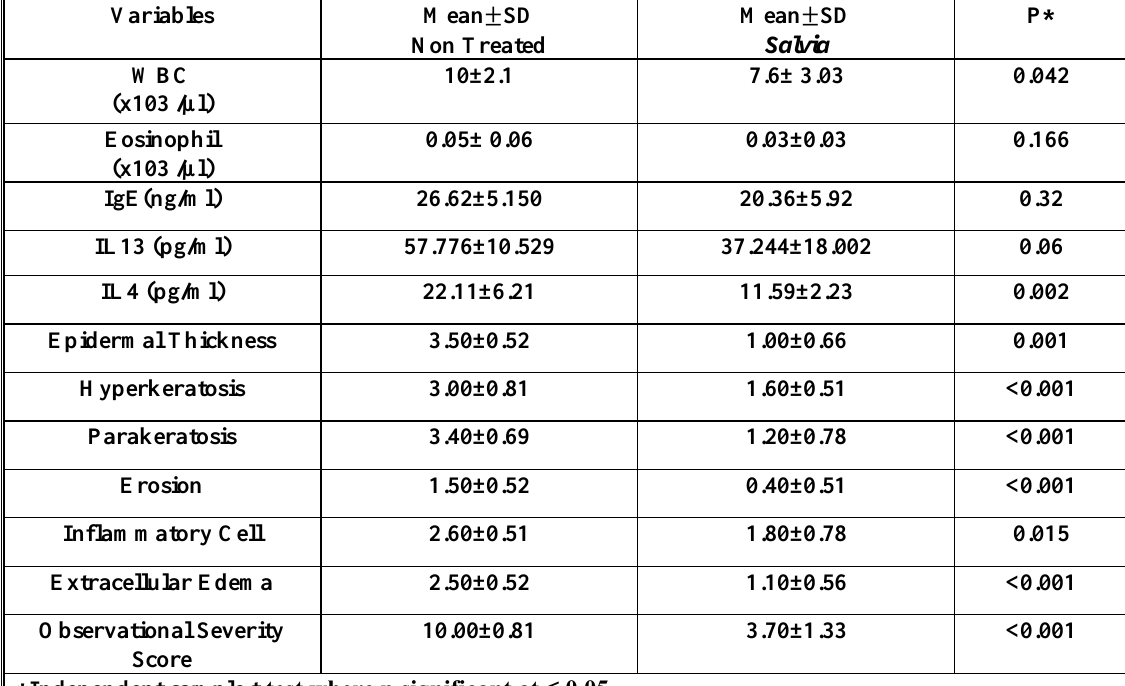
Table 3. Comparisons of non-treated atopic dermatitis induced group with phenolic compound of Salvia frigida treated group regarding WBC, Eosinophil, serum IgE, and skin tissue homogenate of IL-4 and IL- 13, observational severity score, and histopathological